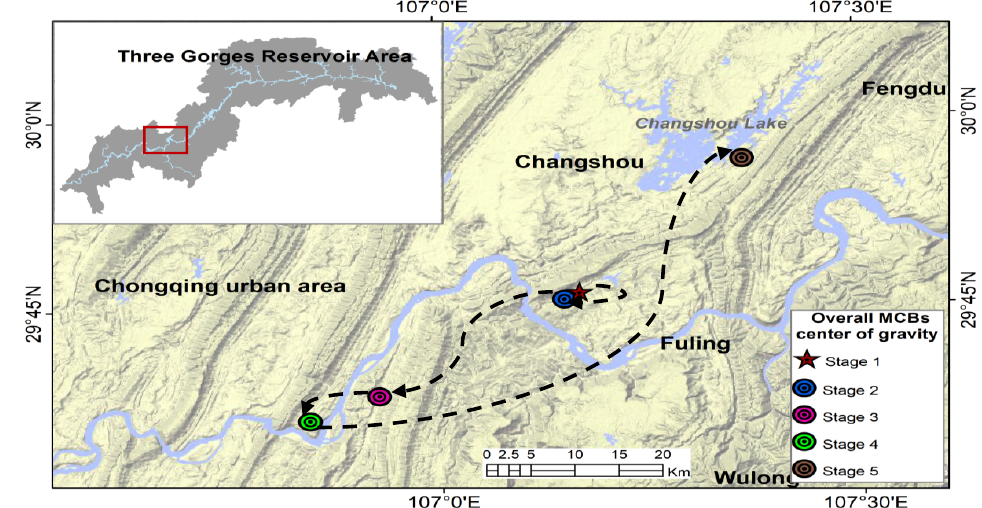
Figure 9. Gravity center migration of MCBs during different impoundment periods.